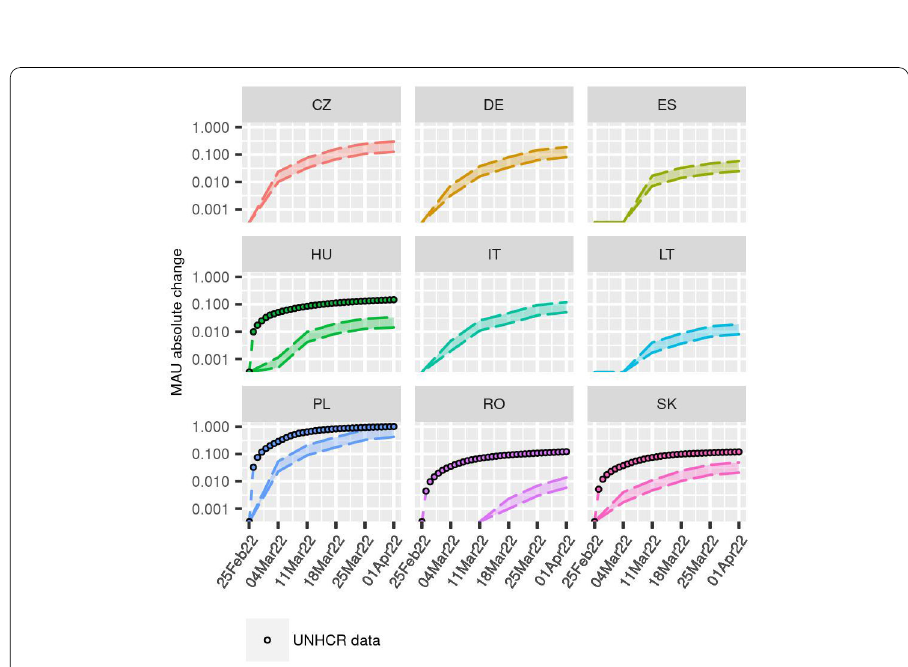
Figure 3 FacebookMAUsvsUNHCRdata . Normalized weekly absolute change of Facebook Monthly Active Users and normalized daily absolute change of arrivals from UNHCR for the available weeks (logarithmic scale)